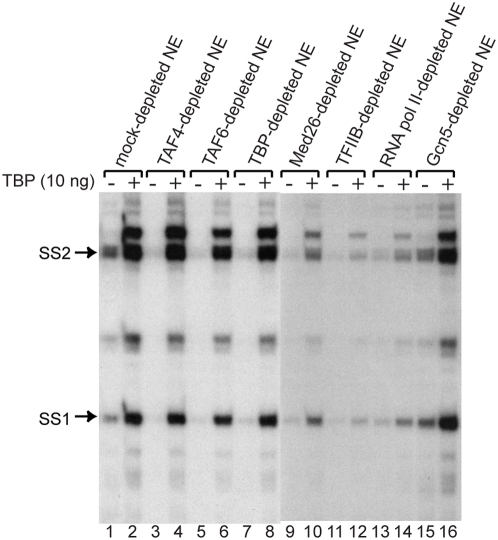
X gene transcription with free TBP requires mediator, TFIIB, and RNA pol II but not TAFs or Gcn5.HeLa NE was immunodepleted of the indicated factors and tested for X gene transcription activity with or without addition of free TBP. Abolishment of X gene transcription by TAF4-, TAF6-, TBP-, MED26-, TFIIB-, or RNA pol II-depletion (lane 1 vs. lanes 3, 5, 7, 9, 11, and 13) confirms that these factors contribute to the X gene transcription but Gcn5 doesn't (lane 1 vs. lane 15). The strong activation of X gene transcription by addition of a higher-than-endogenous level of free TBP to the mock-, TAF4-, TAF6-, TBP-, and Gcn5-depleted NEs (lanes 2, 4, 6, 8, and 16) indicates that these depleted factors were not necessary for X gene transcription by the mechanism using free TBP. In contrast, the absence of such activation by addition of free TBP to MED26-, TFIIB-, or RNA pol II-depleted NE (lanes 10, 12, and 14) indicates that these three factors are required for the free TBP-driven transcription to occur. For more details, see text.